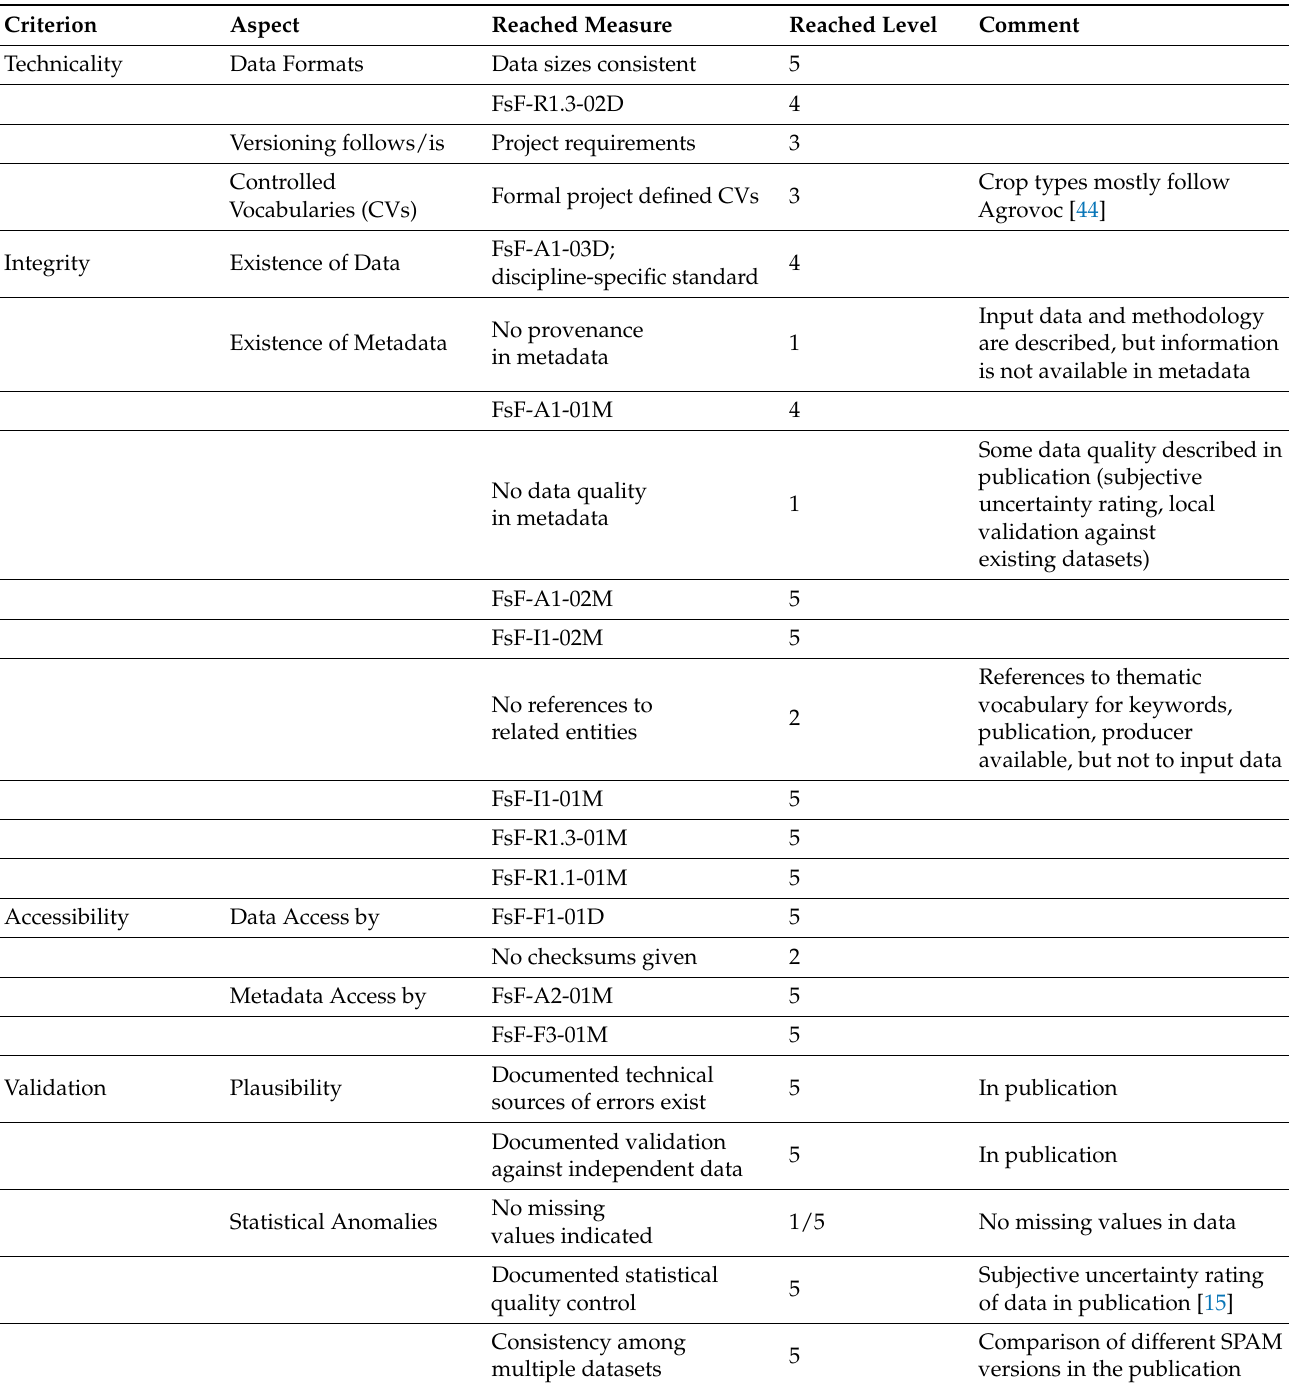
Table 16. Evaluated data maturity of SPAM2010 example